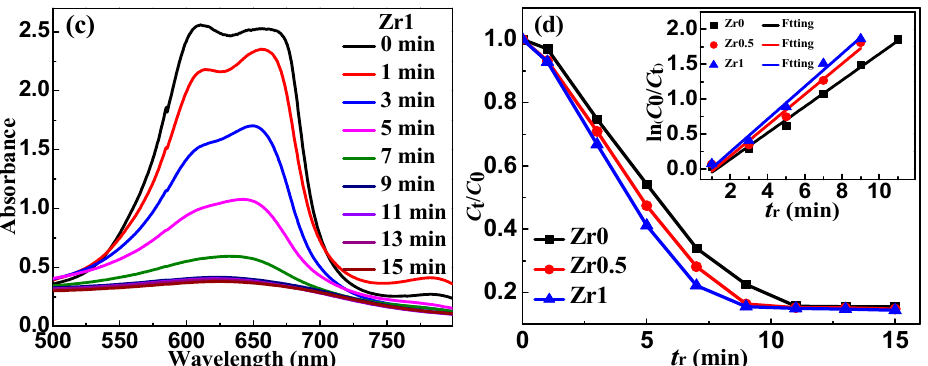
Figure 3. The ultraviolet–visible (UV–Vis) absorbance spectra of methylene blue (MB) solution during the Fenton-like reactions using as-spun ( a ) Zr0, ( b ) Zr0.5 and ( c ) Zr1 ribbons and ( d ) the normalized concentration change of MB solution during the degradation process. The inset in ( d ): the ln( C 0 / C t )- t r curves for as-spun Zr0, Zr0.5 and Zr1 ribbons ( T = 298 K, pH = 3, C H2O2 = 1 mM, ribbon dosage = 0.5 g L − 1 and C MB = 100 mg L − 1 ). Symbols show the experimental data while solid lines are fitting results.